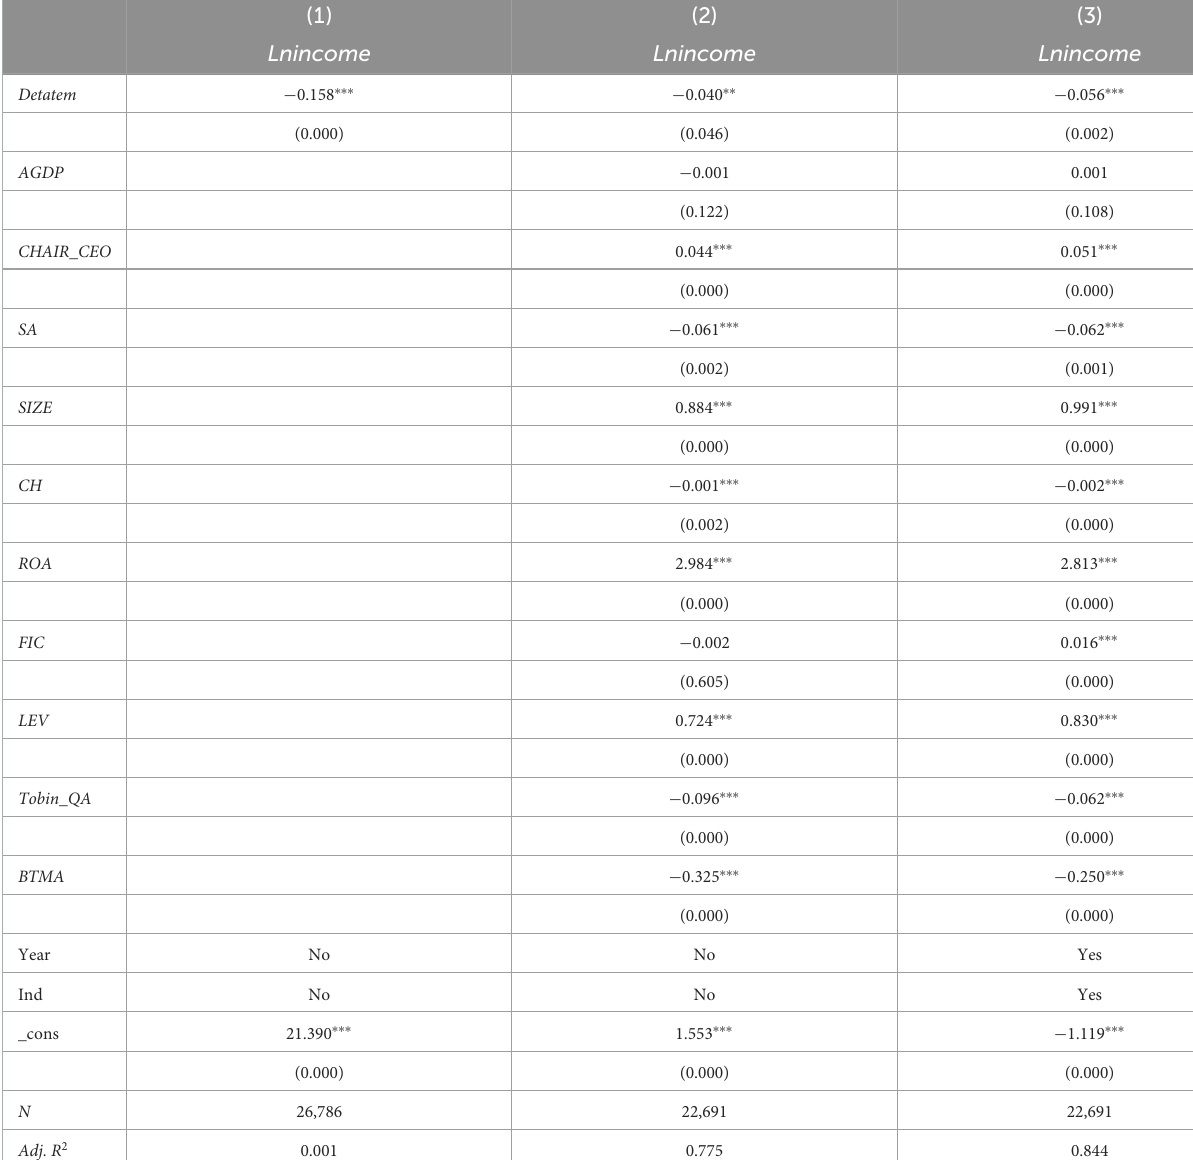
TABLE 4 Impact of climate change on enterprises’ sales